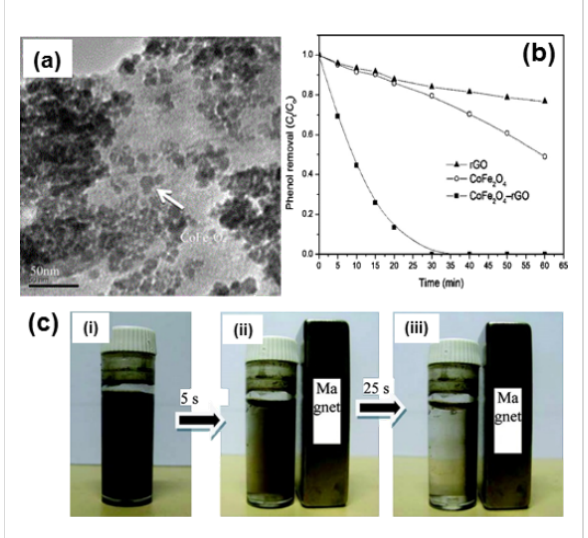
Figure 11: (a) TEM image of CoFe 2 O 4 − rGO hybrid. (b) Phenol degra- dation using CoFe 2 O 4 − rGO/PMS (reaction conditions: [phenol] = 20 mg/L, [PMS] = 0.3 g/150 mL, [catalyst] = 10 mg/150 mL). (c) Photographs of the separation and redispersion processes of CoFe 2 O 4 − rGO: (i) without external magnetic field, and (ii, iii) with external magnetic field. Reprinted (adapted) with permission from [320], copyright 2012 American Chemical Society.